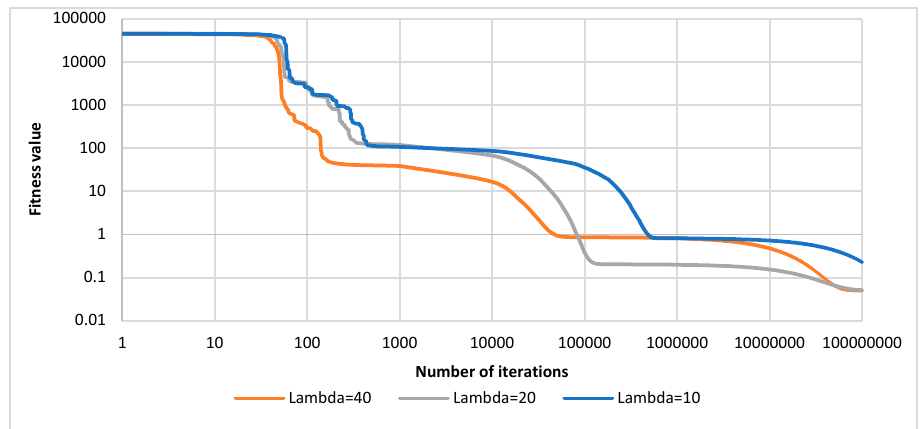
Figure 12. Dependence of the fitness value on the number of iterations for different lamba values.